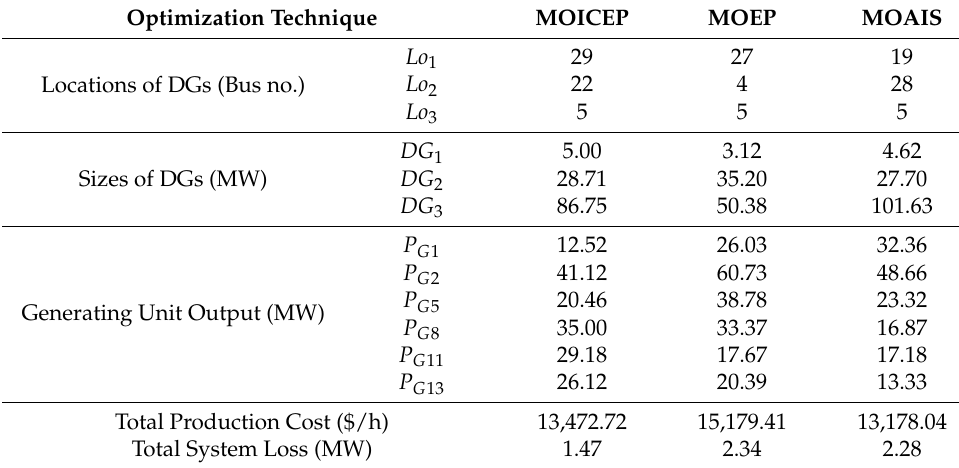
Table 20. Results of the integrated ED problem with a valve-point loading effect and DG installation of the IEEE 30-Bus RTS ( w 1 = 0.1 and w 2 = 0.9). Optimization Technique MOICEP MOEP MOAIS Lo 1 Locations of DGs (Bus no.)